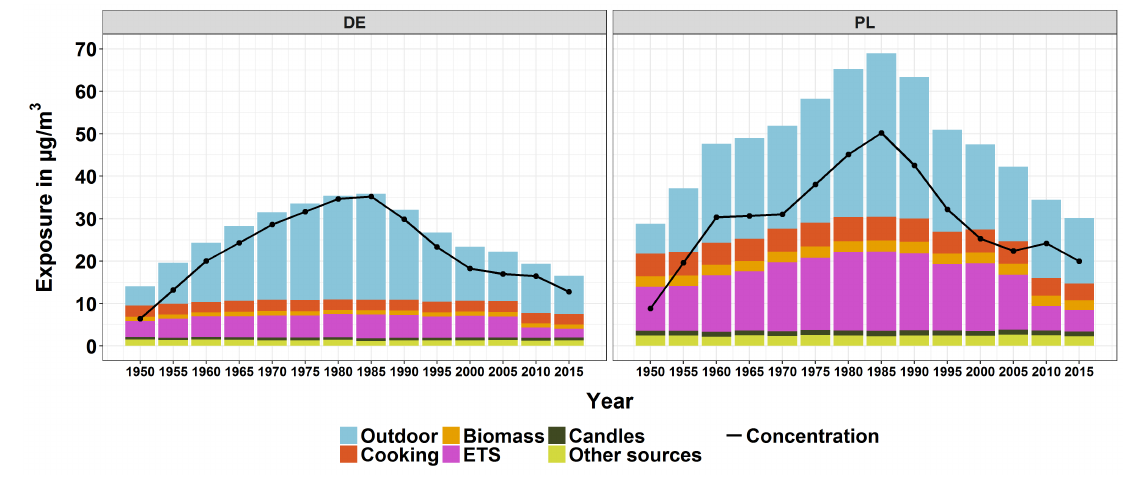
Figure 2. Population-weighted arithmetic mean PM 2.5 exposure by source (infiltration from outdoors, cooking, wood burning, smoking, candle/incense burning and other sources) for Germany and Poland from 1950 to 2015. The black line indicates the average background PM 2.5 concentrations in the two